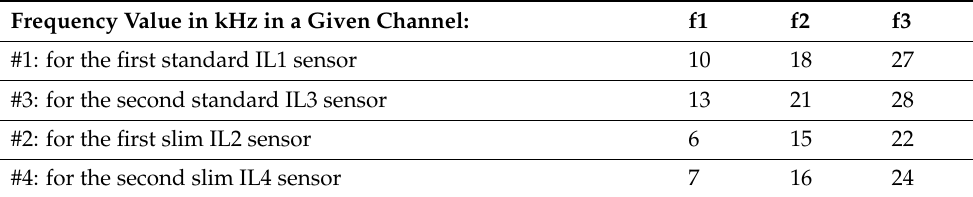
Table 1. The list of excitation frequencies applied in the